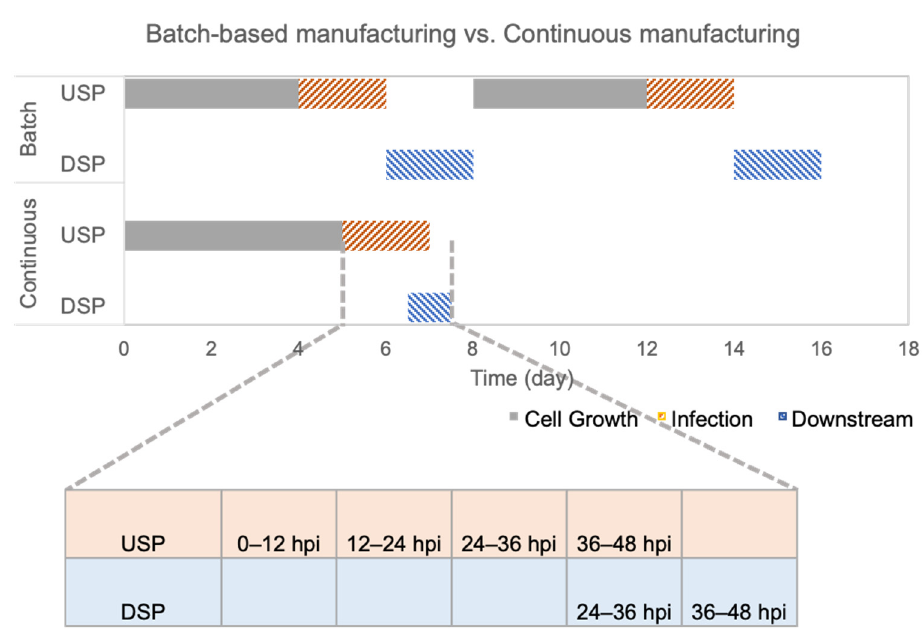
Figure 8. Comparison of the processing time of batch-based manufacturing and continuous manufacturing in the production of rVSV-SARS-CoV-2 in cell cultures, infection phases, and downstream processing.